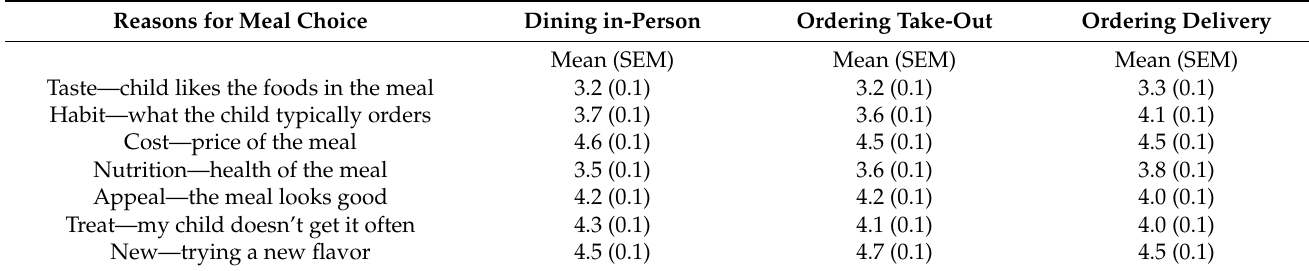
Table 6. Parent ranking of the importance of different factors when choosing a restaurant meal for their child over the past 2 months ( n = 467) a,b .